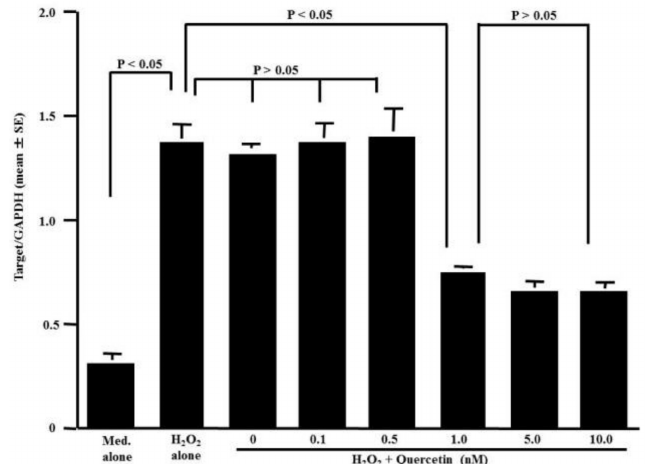
Figure 4. Influence of quercetin on TRX mRNA expression in HNEpCs. Nasal epithelial cells (5 × 10 5 cells) were stimulated with 50 µ M H 2 O 2 in the presence or absence of quercetin for 12 h. TRX mRNA levels in the cultured cells were examined by RT-PCR. The data are expressed as the mean Target/GAPD ± SE of triplicate cultures. One representative experiment of two is shown in this figure. Med. alone: Medium alone.